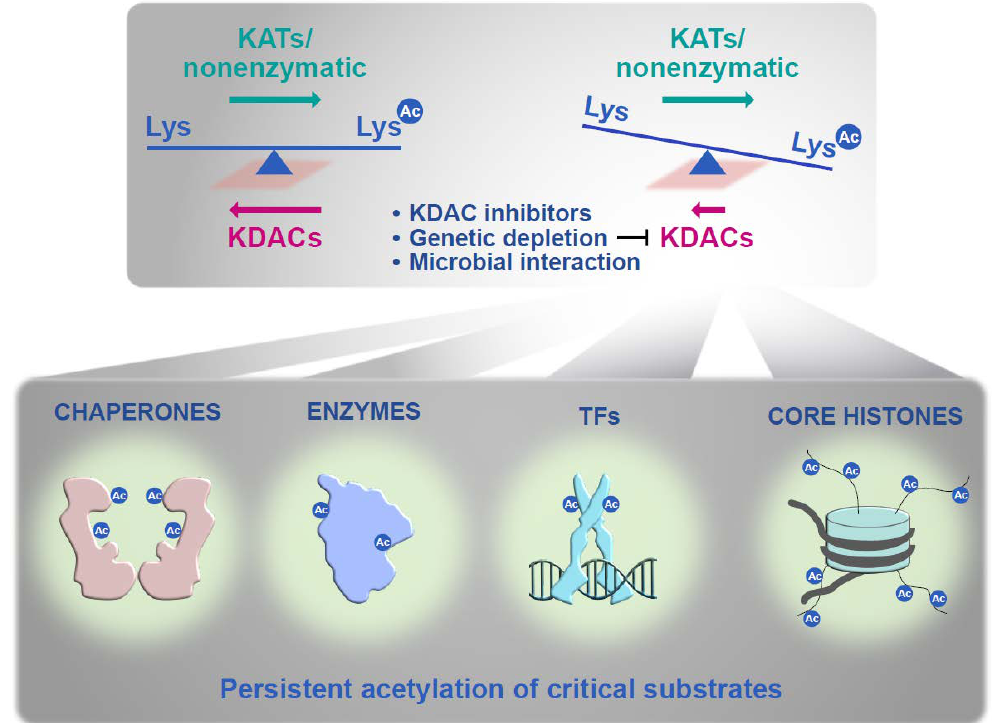
Figure 1. Maintenance of a delicate acetylation equilibrium. Disturbance of lysine deacetylase (KDAC) activity results in a destabilization towards persistent acetylation of critical